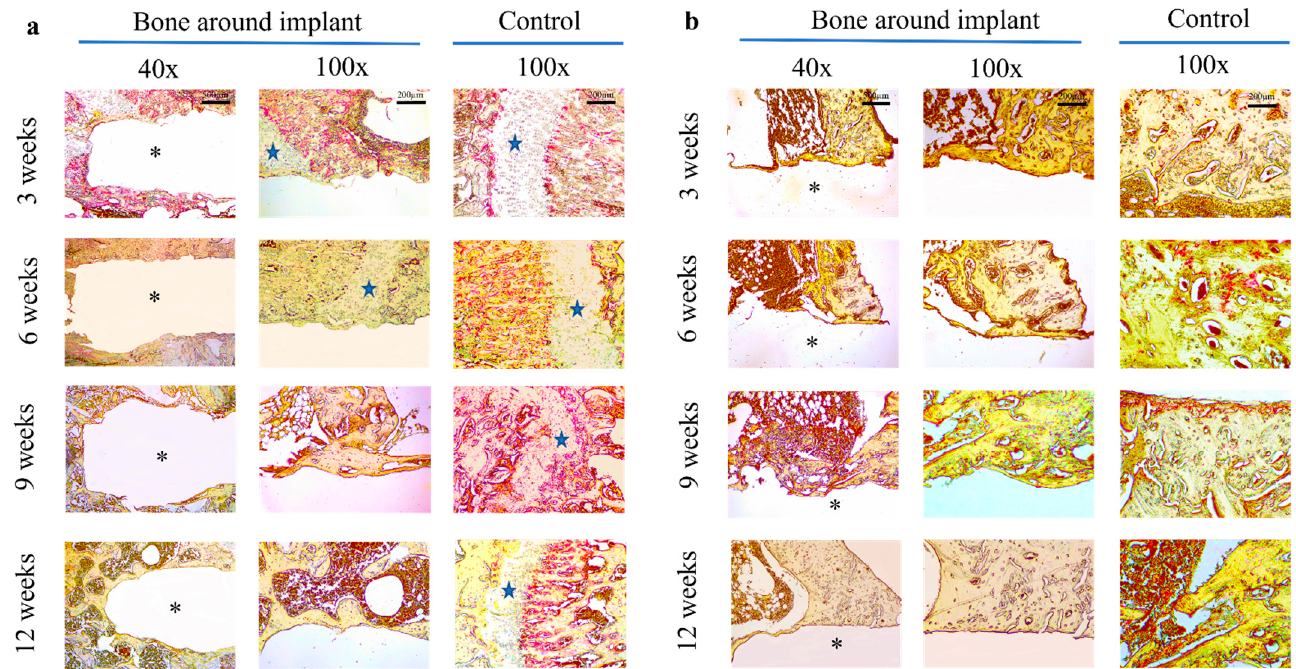
Figure 7. Mitigation of bone resorption surrounding magnesium implant in ( a ) distal femoral epiphysis and ( b ) tibial diaphysis at 3, 6, 9, and 12 weeks. TRAP (tartrate-resistant acidic phosphatase) staining of the bone surrounding the magnesium rod compared with the control area in the same bone. The asterisk indicates the position of the magnesium rod and the epiphyseal growth plate is marked as a blue star.